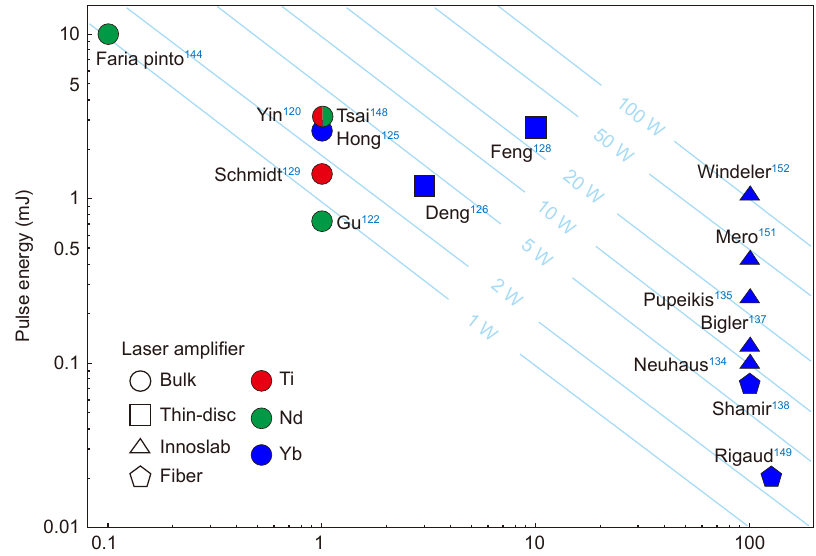
Fig. 6 | Graphical summary of the performance of high average power SWIR OPCPA systems. Color coding of data points denotes the gain medium of pump laser, while different shapes indicate the configuration of laser